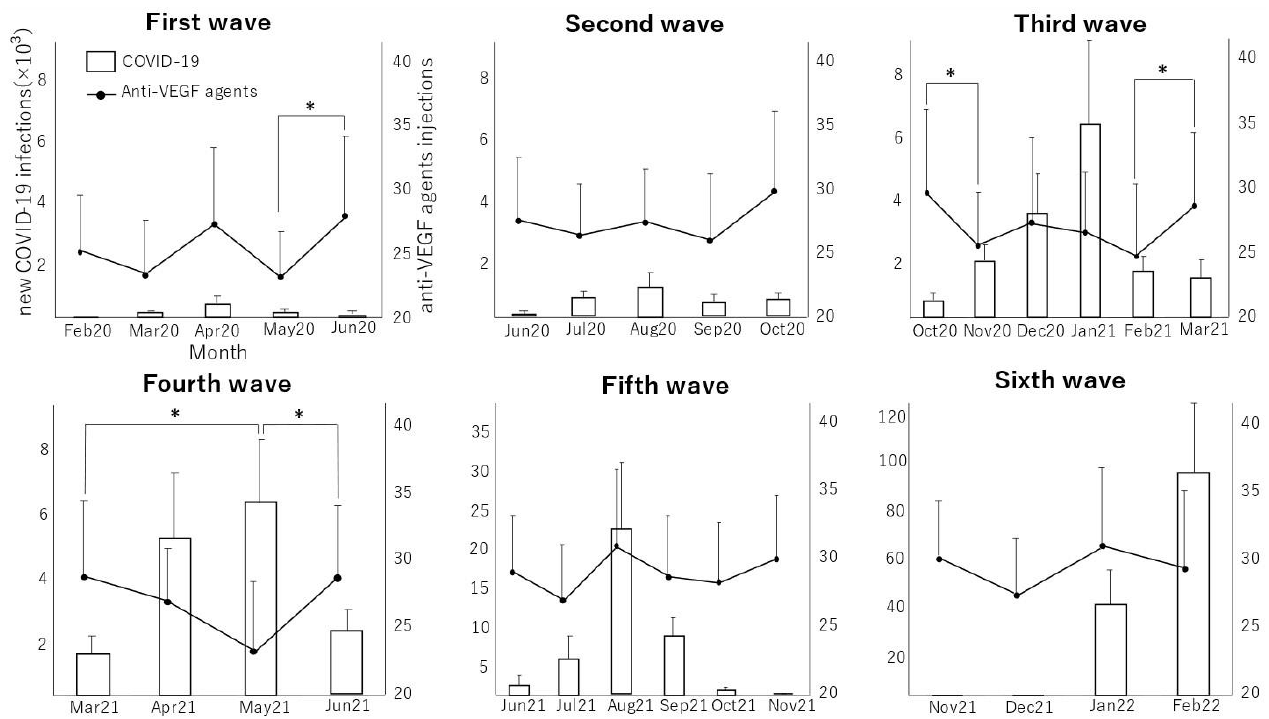
Figure 1. Changes in the number of new COVID-19-positive patients and in the number of injections of anti-VEGF agents during the waves of the COVID-19 pandemic. The data are shown as mean ± standard error. * p <